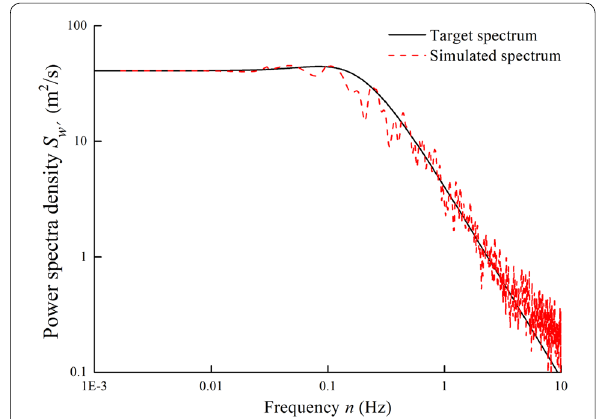
Figure 5 Comparison of simulated spectrum and target